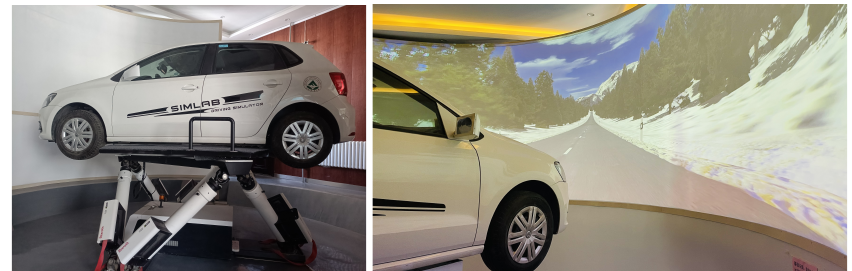
Figure 16. The 6DOF driving simulator of Northeast Forestry